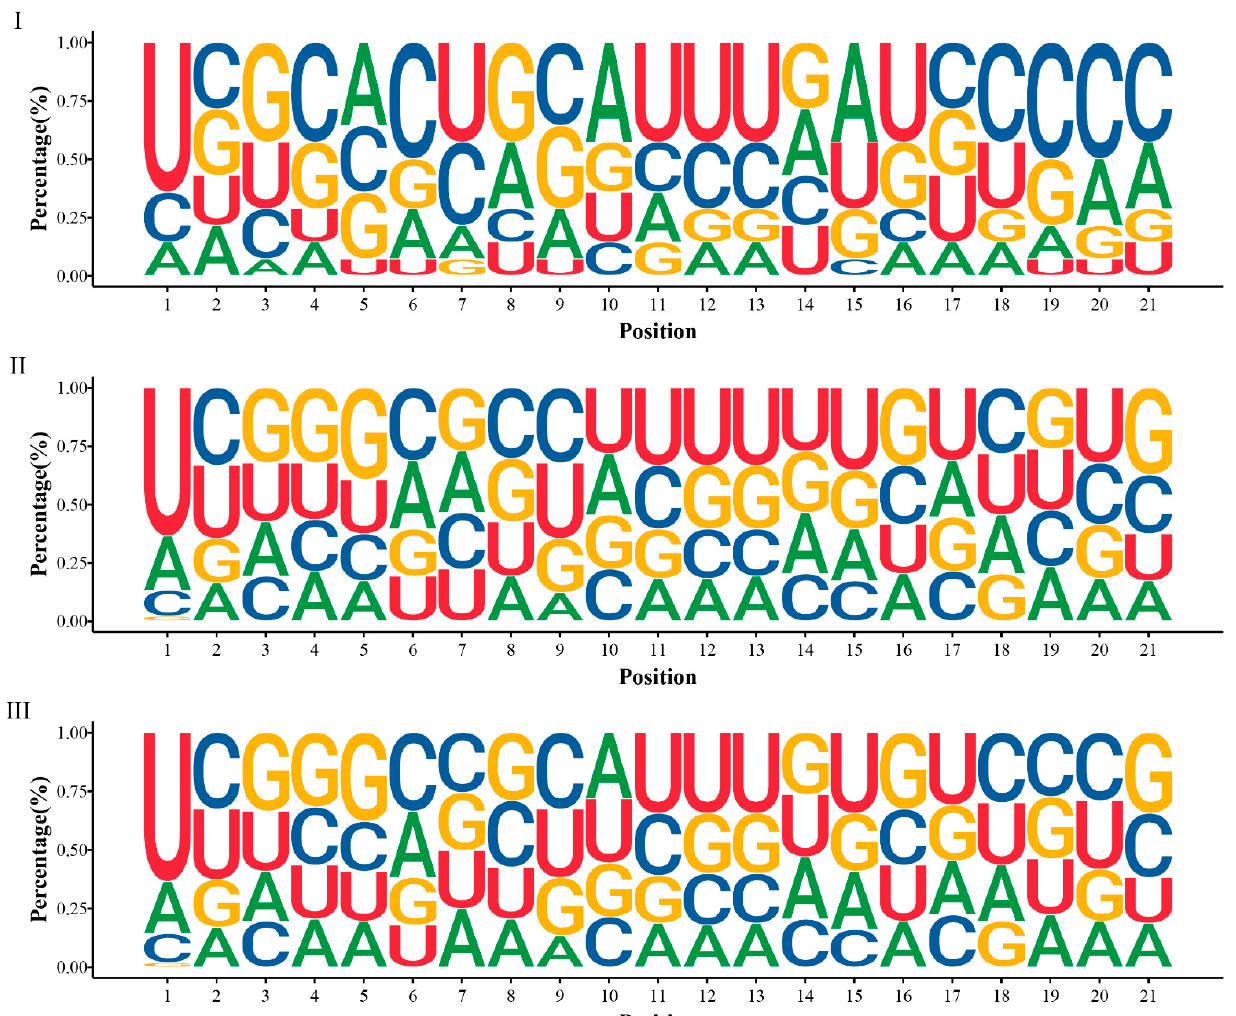
Figure 3. Base ratio of 21 nt miRNAs at each position, ( I ) for conserved miRNAs, ( II ) for novel miRNAs, and ( III ) for all miRNAs. For each position, larger percentages of bases are closer to 1 on the